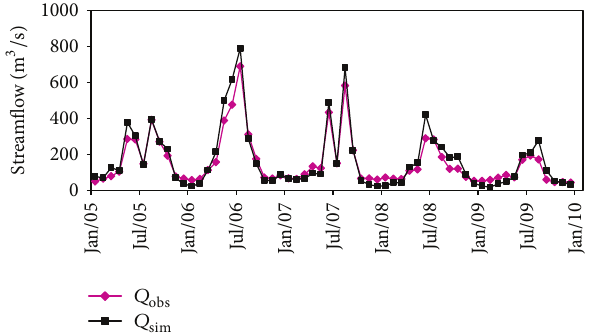
is simulated sim Figure 8: Comparison between monthly averaged simulated and observed streamflow at Shilong